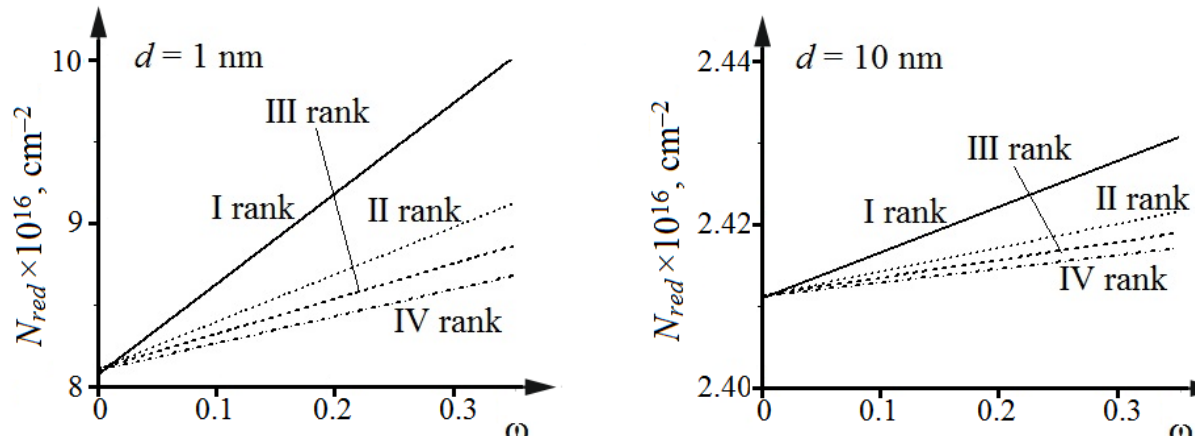
Figure 3 . Dependence of the surface concentration of chemisorbed molecules of the reducing gas on the porosity of sensory